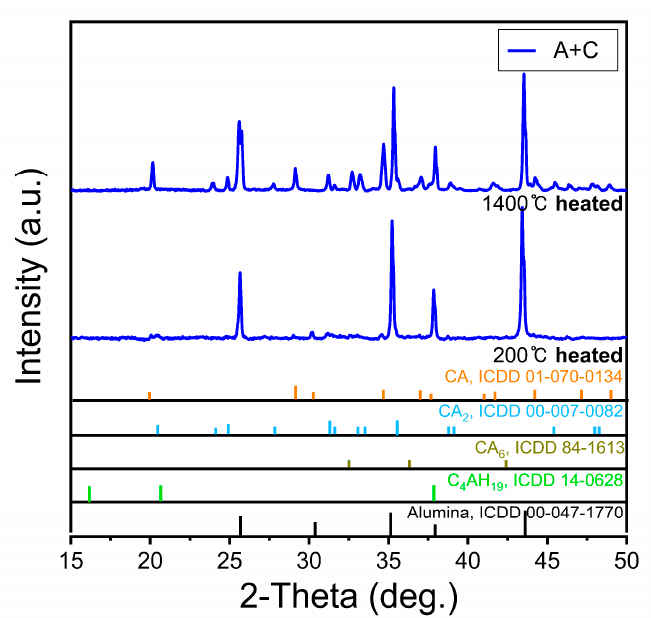
Figure 8. XRD peaks after heat treatment at 200 °C and 1400 °C of alumina sand and CAC mixed molded body.